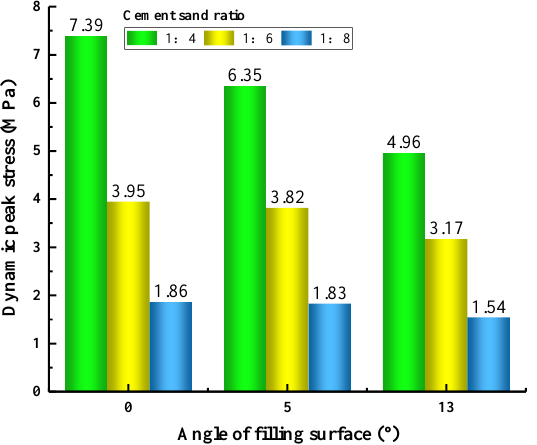
Figure 11. Relationship between angle of the filling surface and the dynamic peak strength.